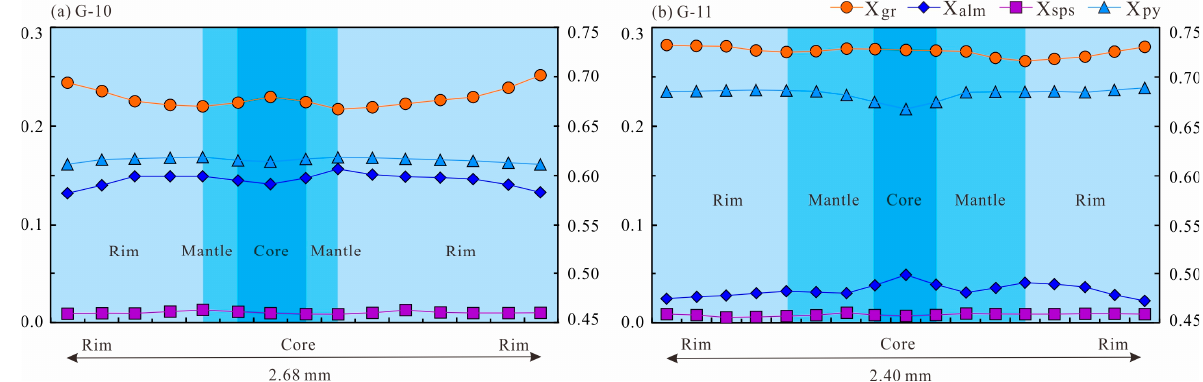
Figure 5. Compositional profiles of garnet. X alm = Fe 2+ /(Fe 2+ + Mn + Mg + Ca), X sps = Mn/(Fe 2+ + Mn + Mg + Ca), X py = Mg/(Fe 2+ + Mn + Mg + Ca) and X gr = Ca/(Fe 2+ + Mn + Mg + Ca) across garnet grains